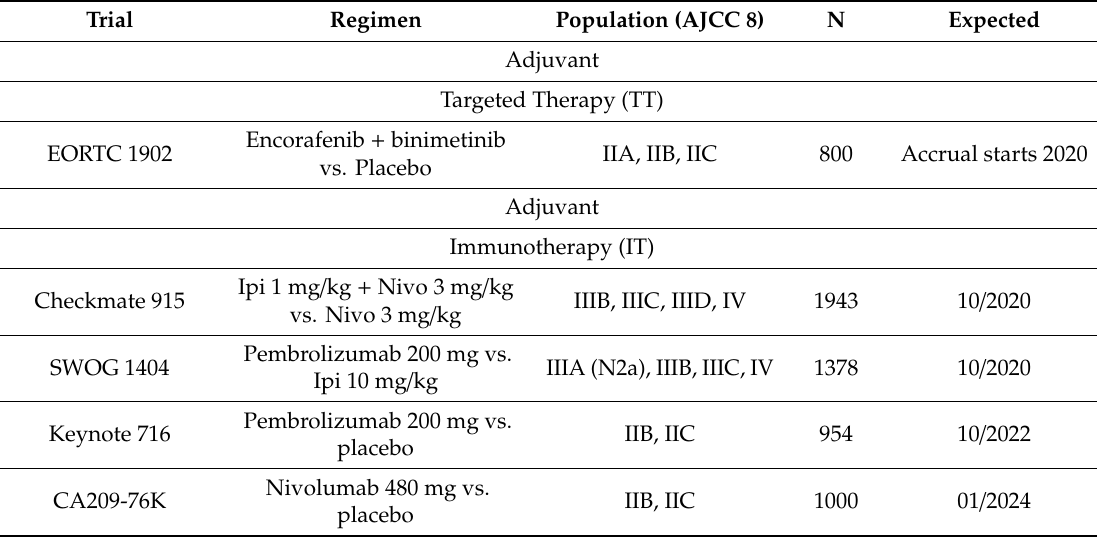
Table 3. Ongoing / planned adjuvant